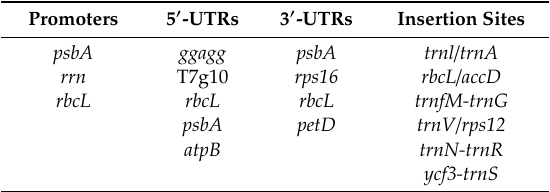
Table 2. Promoters, untranslated regions, and insertion sites commonly used for plastid